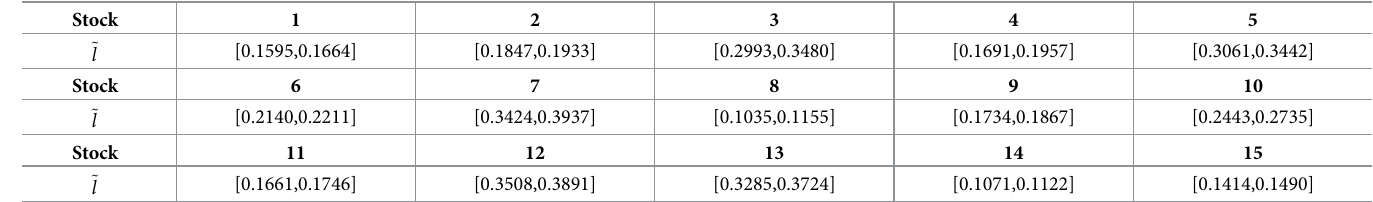
S1 Fig. Position relation of two interval numbers of Example 1.